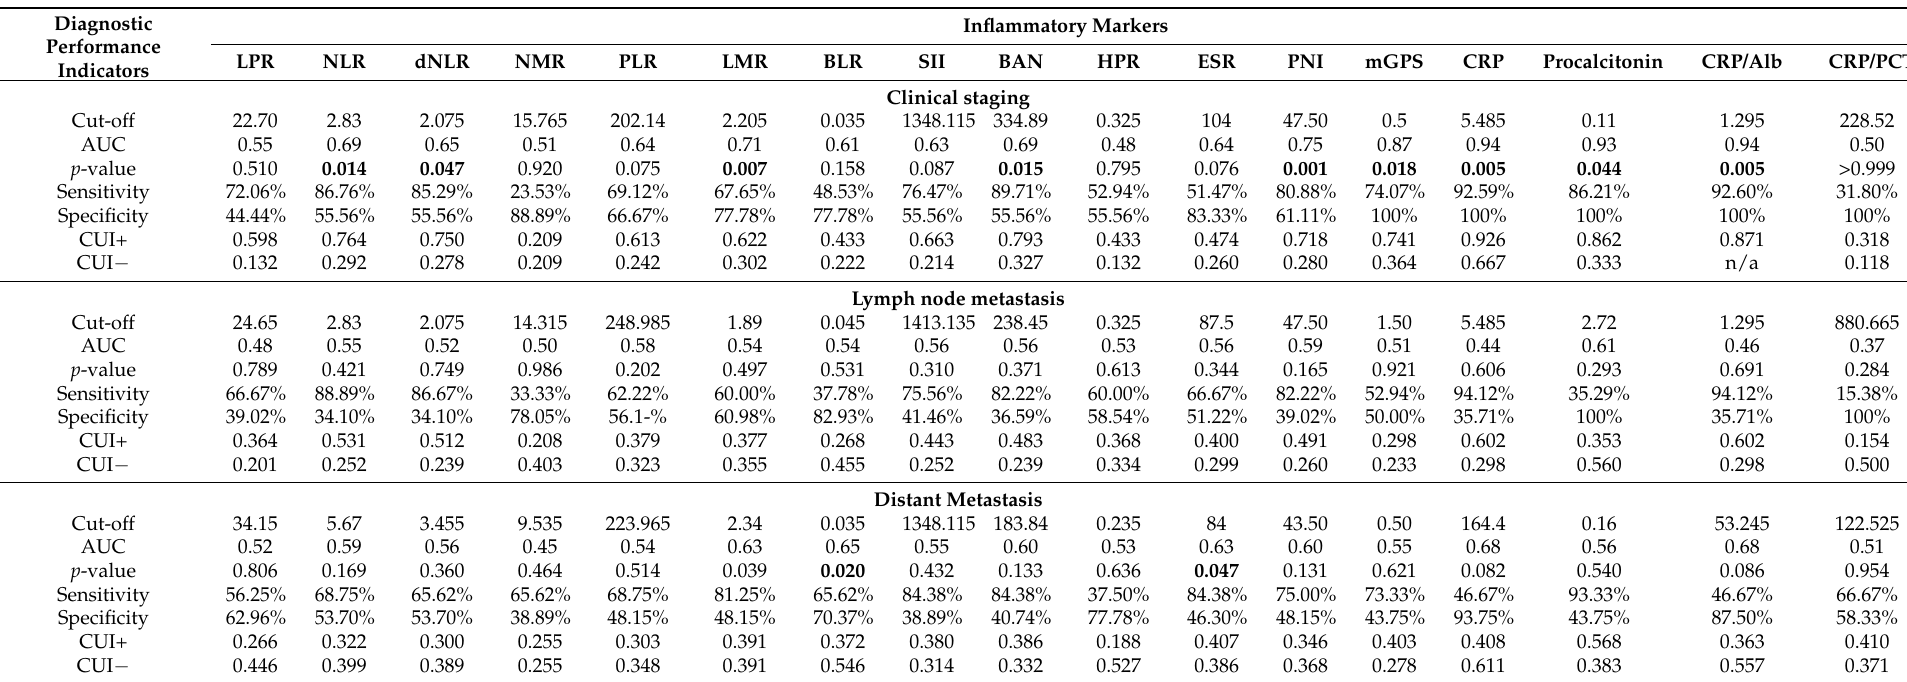
Table 4. Cut-offs and diagnostic indicators performance of inflammatory